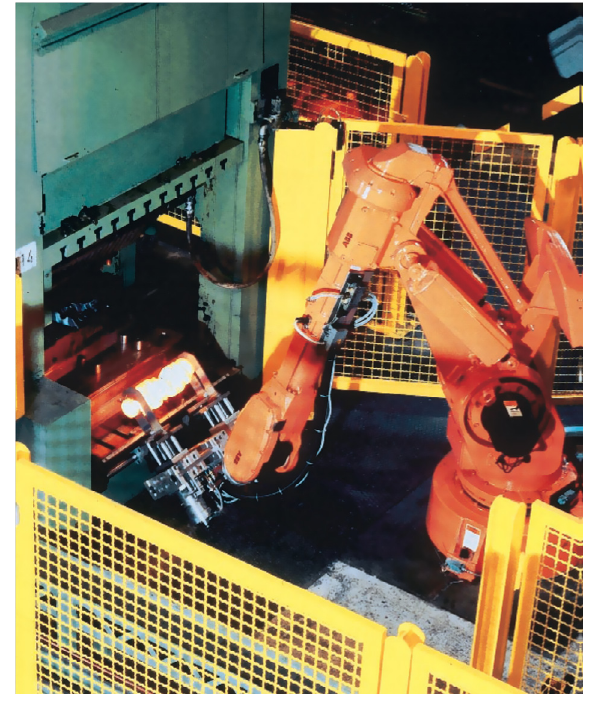
Figure 5. Robot handling crankshafts for the auto industry